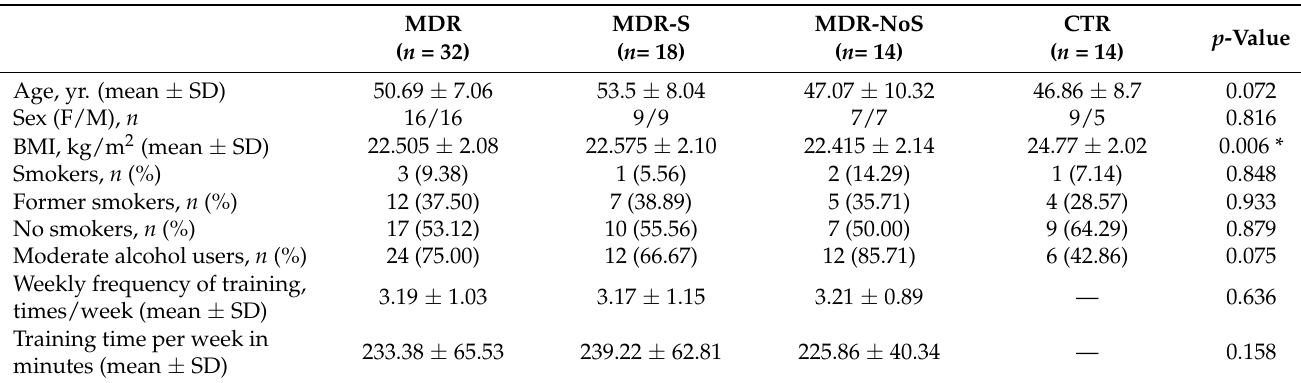
Table 1. The main characteristics of the study